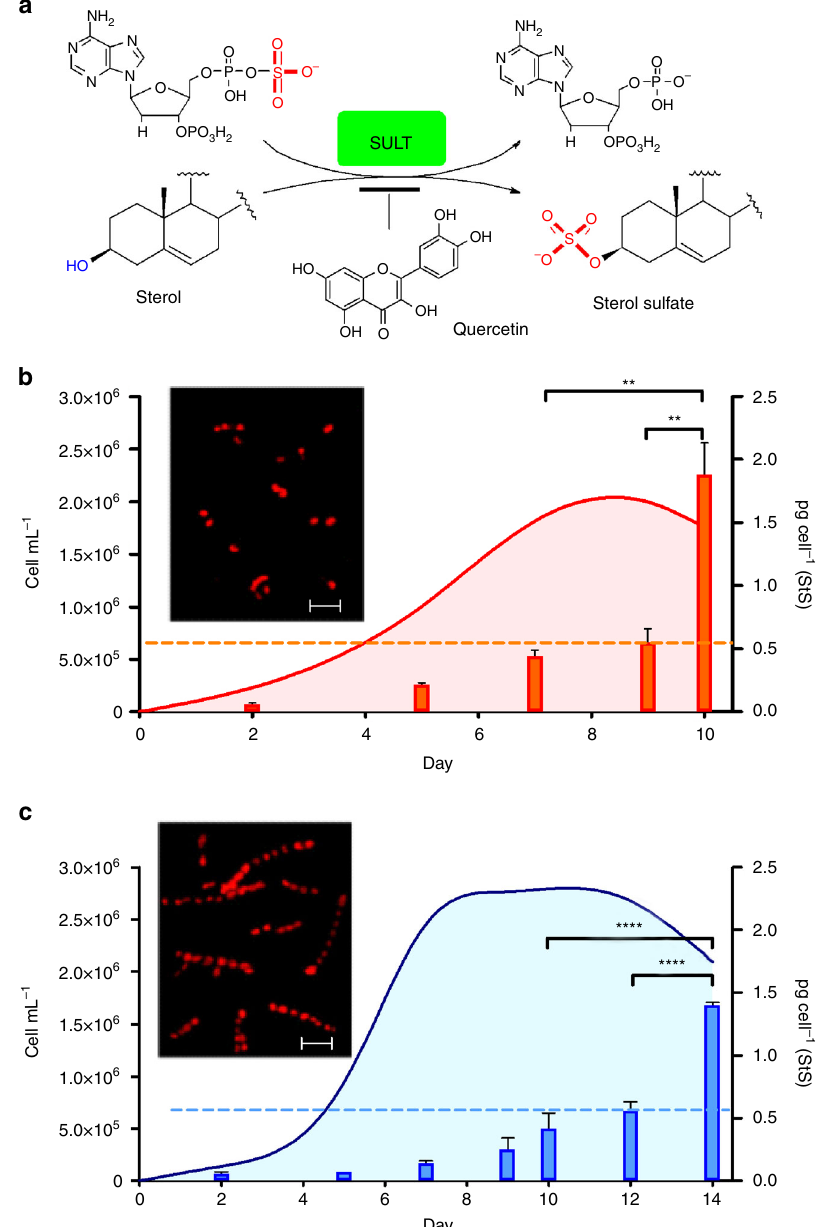
Fig. 4 Reduction of cellular levels of StS improves growth and duration of S. marinoi cultures. a Biosynthesis of sterol sulfates by sulfotransferase (SULT) and 3 ′ -phosphoadenosyl-5 ′ -phosphosulfate (PAPS) as donor of the sulfonic group. Inhibition of this reaction by quercetin induces reduction of cellular levels of sterol sulfates. b , c Response of S. marinoi to the SULT inhibitor quercetin. The graphics show cell growth (cell mL − 1 ) and cellular concentration (pg per cell) of sterol sulfates in diatom cultures maintained under standard conditions (red) and after addition of 20 μ g mL − 1 quercetin (blue). Cells were counted daily by Burker chamber and chlorophyll a fl uorescence was measured. Data are means ± s.d. of quintuplicates of three independent experiments; ** P < 0.01, **** P < 0.0001 (Tukey ’ s Multiple Comparison test). Inserts show fl uorescence micrographs of control and treated cells in stationary phase (day 9) at ×200 magni fi cation captured by an LP615 emission fi lter for red chlorophyll auto fl uorescence. Scale bar depicts 20 µ